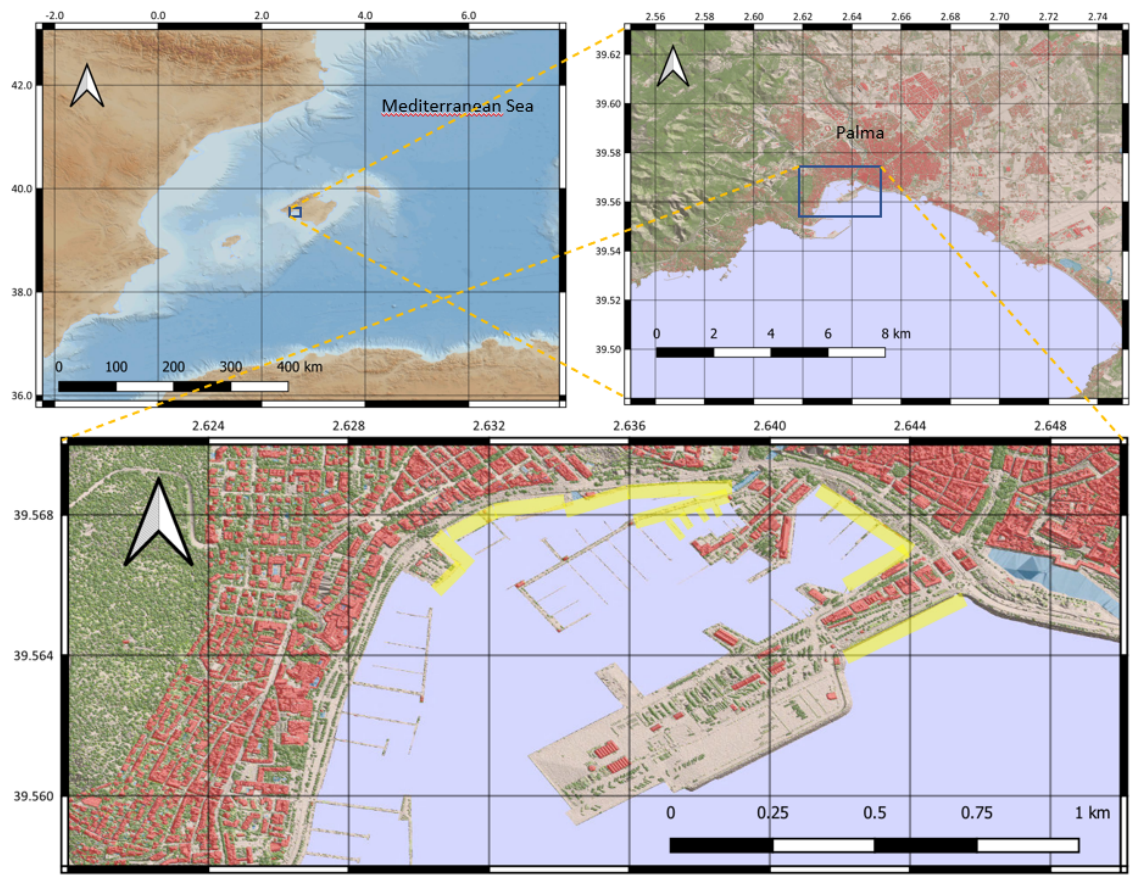
Figure 1. Study area location. Zones where images were obtained are highlighted in yellow in the lower panel.